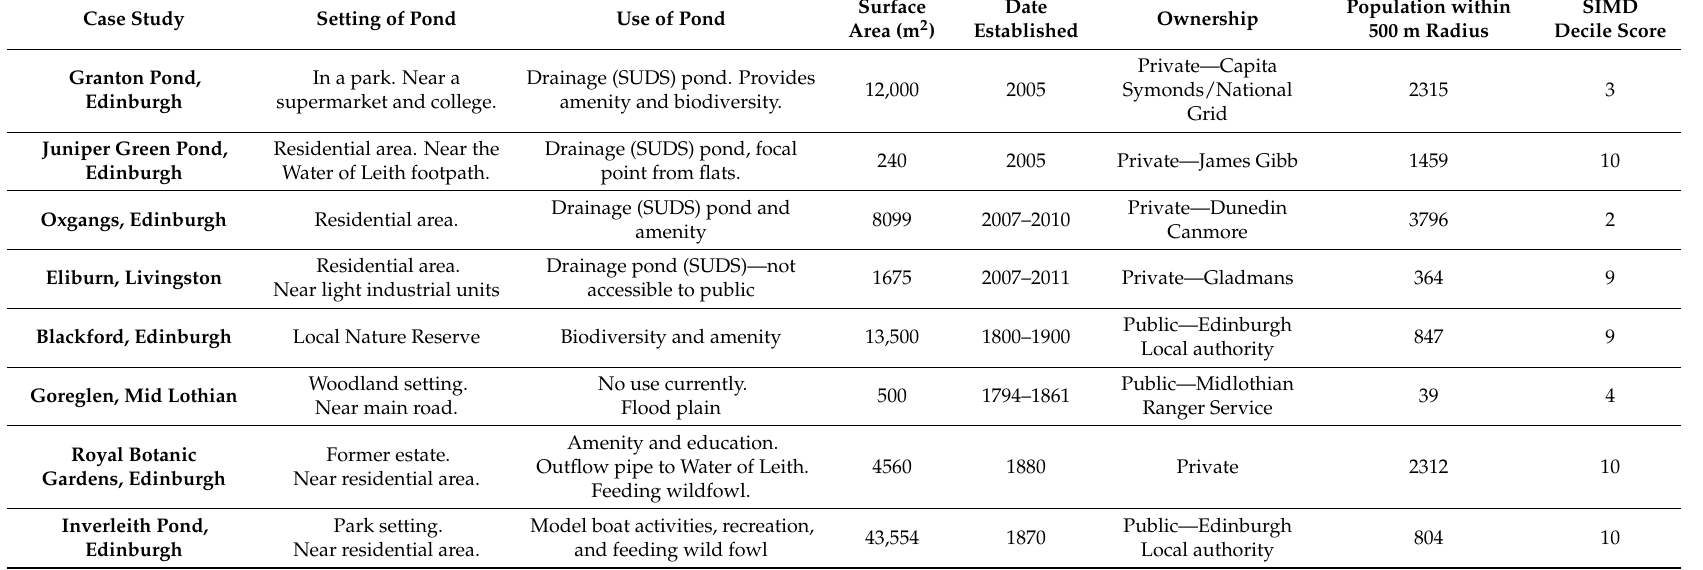
Table 1. Describes the setting of each pond, ownership, and the known uses. The main purpose of each pond is described, and some additional notes about amenity and biodiversity. This also highlights why the ponds were chosen (with SUDS ponds being compared to those with natural origins). Scottish Index of Multiple Deprivation (SIMD, hereafter) scores for each case study are